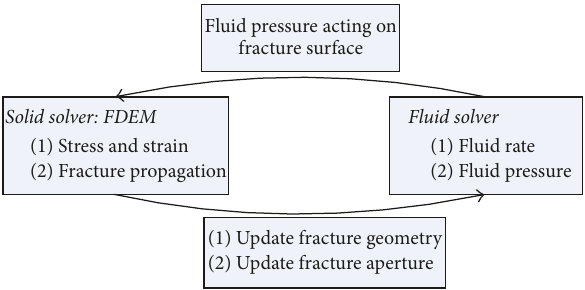
Figure 8: Interaction between the solid solver and fluid solver in FDEM-Fluid.